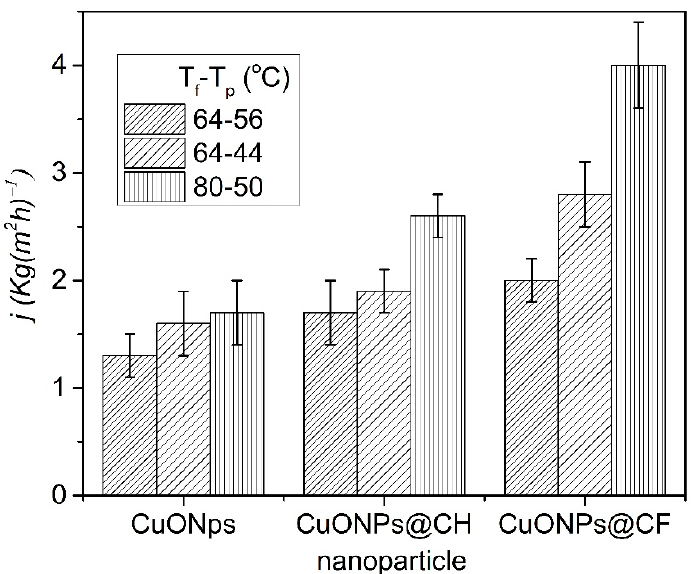
Figure 8. Performance of membranes prepared with 5% CuONPs and 10% CuONPs@CH and CuONPs@CF.